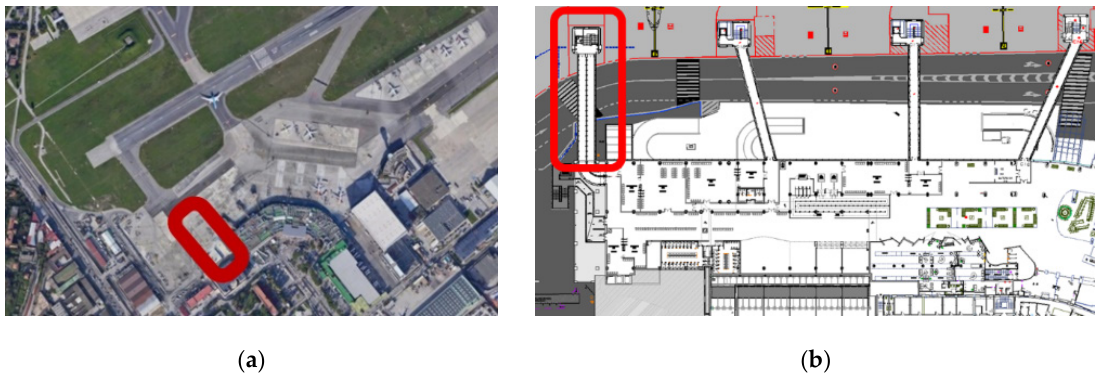
Figure 2. Case study area: ( a ) Google maps view; ( b ) design project top view.